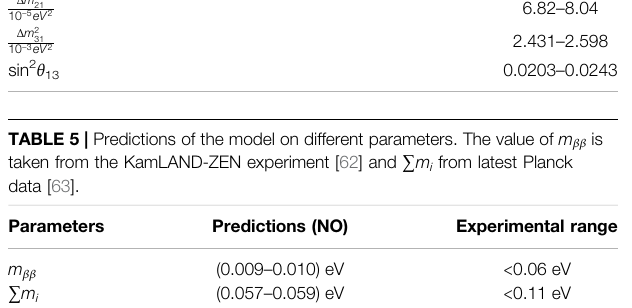
TABLE 4 | Latest global fi t neutrino oscillation data [60, 61]. Oscillation parameters